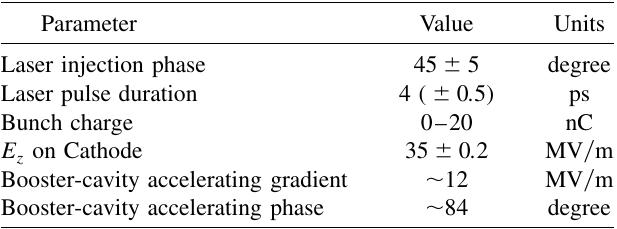
Typical settings for the rf-gun, accelerating section, and the photocathode drive laser. An accelerating phase of 90 (cid:5) for the booster cavity corresponds to maximum energy gain.